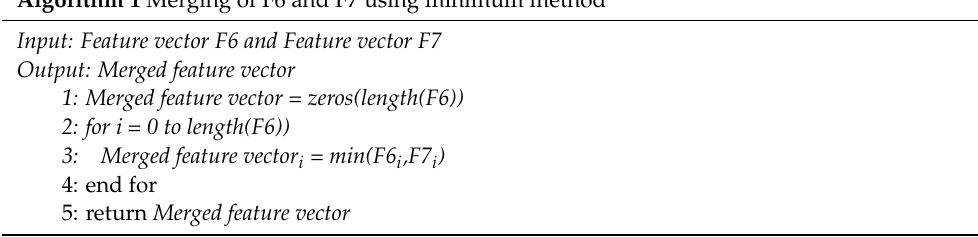
Algorithm 1 Merging of F6 and F7 using minimum method